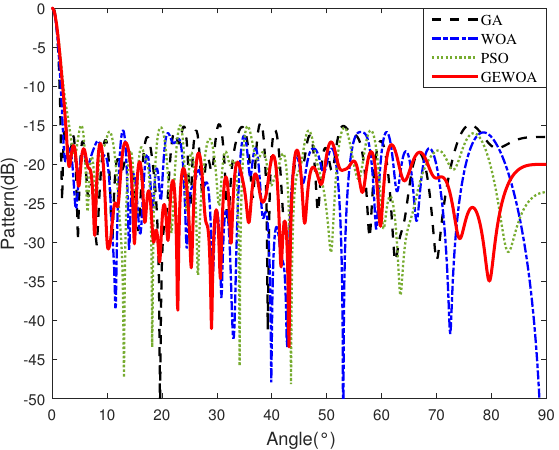
Figure 13. Beampatterns of on-grid arrays (40-element) designed using four intelligence algorithms.